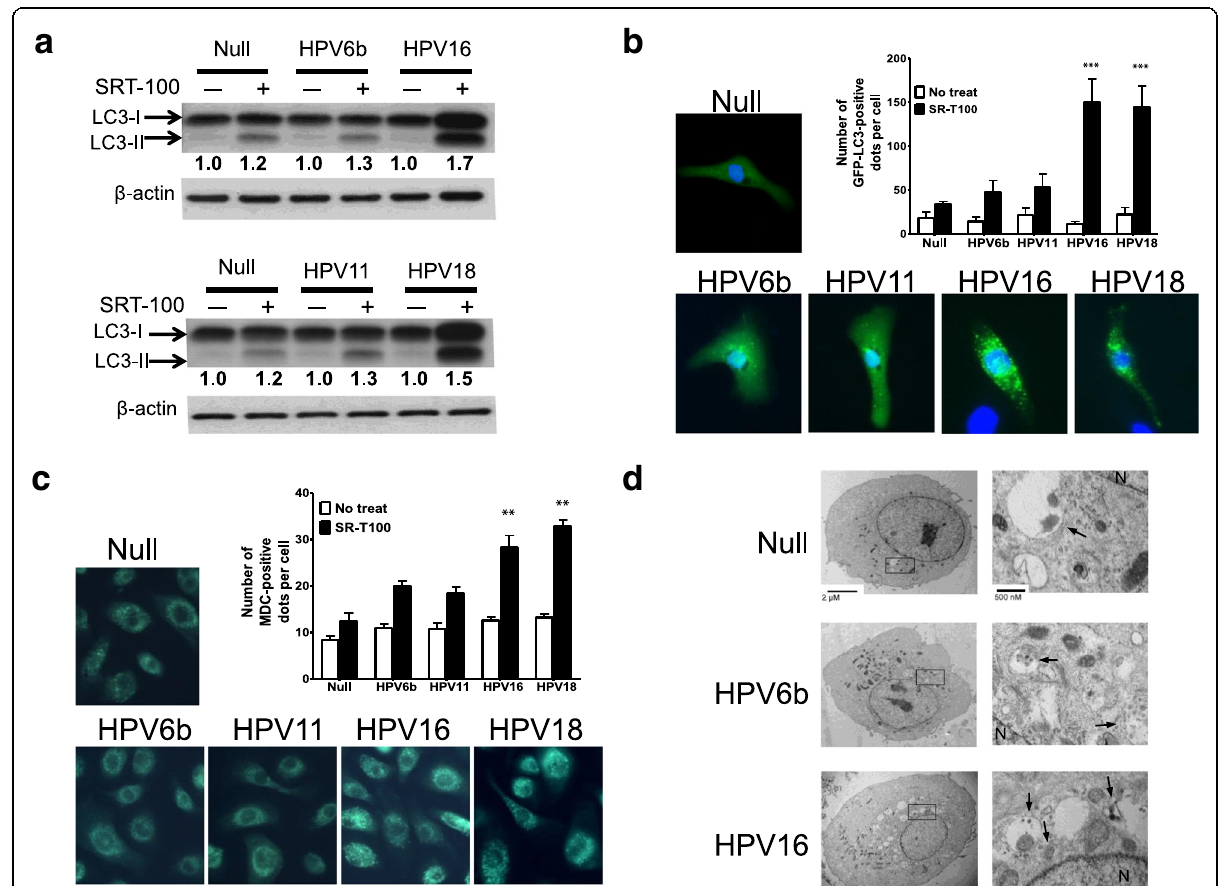
Fig. 3 SR-T100 induced a greater autophagic response in primary epithelial cells expressing HPV16-E6/E7 and HPV18-E6/E7. a Immunoblotting for LC3-I and LC3-II using lysates from primary epithelial cells expressing different types of HPV-E6/E7 treated with or without SR-T100 (5 μ g/ml) for 12 h. Similar results were observed in at least three independent experiments. The number indicates the fold change in the LC3-II/actin ratios in cells treated with SR-T100 versus those without SR-T100 treatment. b Activation of autophagy was observed in primary epithelial cells expressing different types of HPV-E6/E7 that were treated with SR-T100 (5 μ g/ml) for 12 h using GFP-LC3 accumulation. The cells were first transfected with LC3-GFP, infected with different types of Lenti-HPV-E6/E7 viruses, and then treated with SR-T100 for 12 h. GFP-LC3 accumulation was analyzed under a fluorescence microscope (400×), followed by quantitation of the number of green spots per cell showing LC3 accumulation in cytoplasmic vacuoles (inset panel). (*** p < 0.001: HPV16 or 18 versus HPV6b or 11). Representative images of cells that were treated with SR-T100 for 12 h are shown. c Visualization of the activation of autophagy in primary epithelial cells expressing different types of HPV-E6/E7 that were treated with SR-T100 (5 μ g/ml) for 12 h using MDC staining. The formation of autophagic vacuoles was suggested by the interspersed MDC labeling in the cytoplasm observed under a fluorescence microscope (400×). Representative images of cells that were treated with SR-T100 for 12 h are shown. Quantitative results of MDC staining from three independent experiments (** p < 0.001: HPV16 or HPV18 versus HPV6b or HPV11). d Ultrastructural images of the SR-T100-treated cells were obtained using an electron microscope. Primary epithelial cells were infected with or without HPV6b-E6/E7 or HPV16-E6/E7 lentiviruses for 24 h and treated with SR-T100 (5 μ g/ml) for 12 h. The right panel (25,000×) shows the magnified image of the area indicated by the box in the left panel (8,000×). Autophagic vacuoles are denoted by arrows . Note the increased number of autophagic vacuoles in cells expressing HPV16-E6/E7. N,